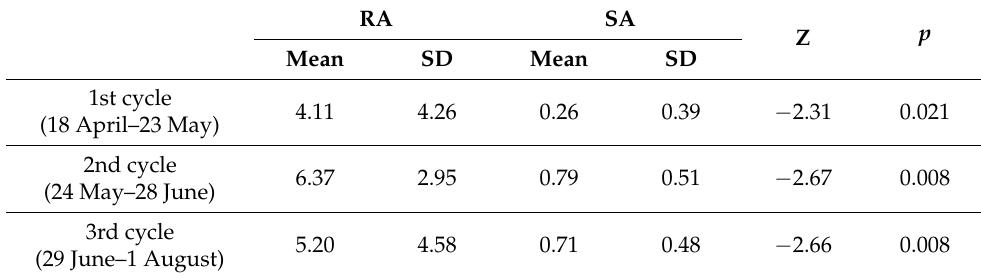
Figure 7. Change in Fe weight ratio, according to cycle: ( a ) sampling areas B, C, and D; ( b ) sampling area A. Table 9. Statistical analysis of the difference in the weight ratio of Fe in the supply air and return air.